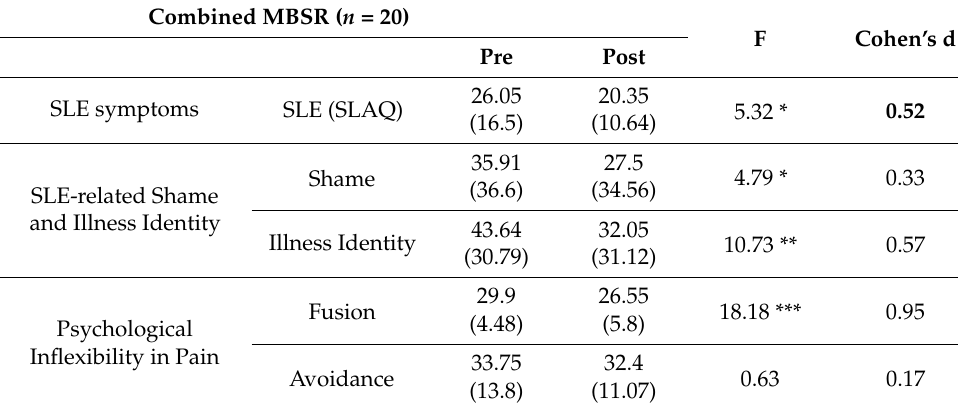
Table 4. Pre- to post-intervention changes in the combined MBSR group.